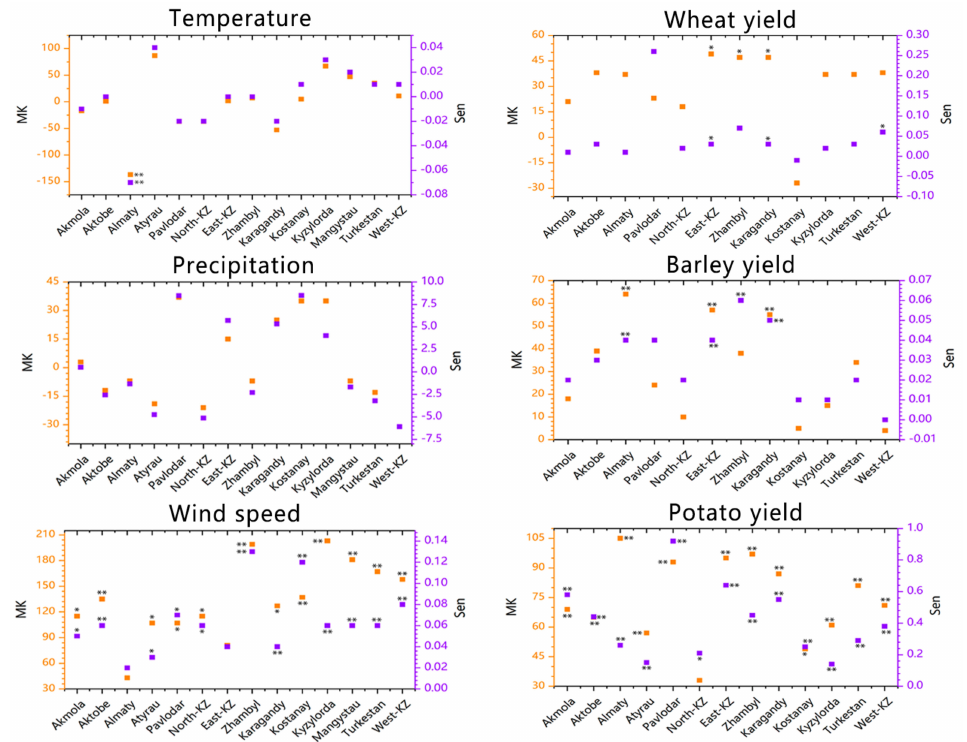
Figure 3. Variation trends of climatic factors and yield of staple crops in Kazakhstan. Note: p < 0.01 **; 0.01 ≤ p < 0.05